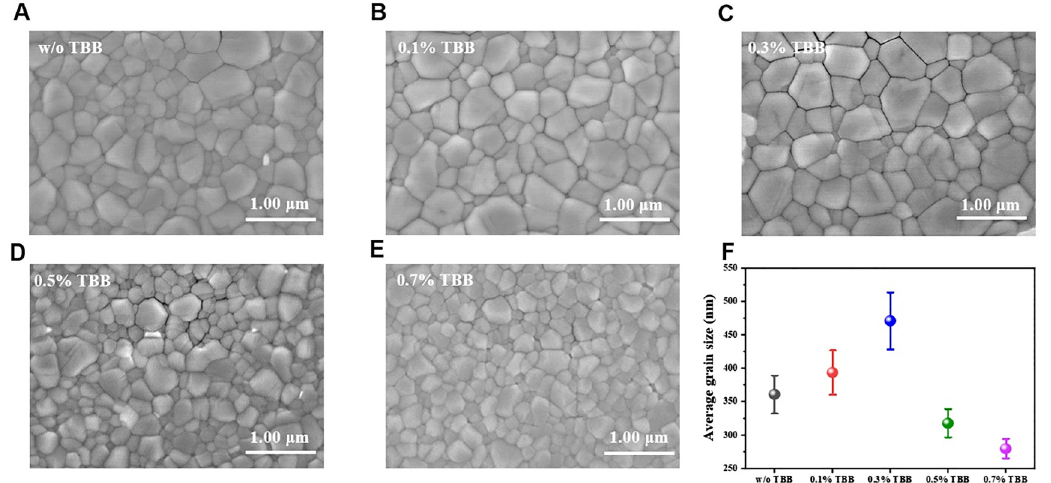
Figure2: Morphologicalcharacterizationsoftheperovskitesamplesdopedwithdifferentconcentrationsof1,3,5-tris(bromomethyl)benzene(TBB).